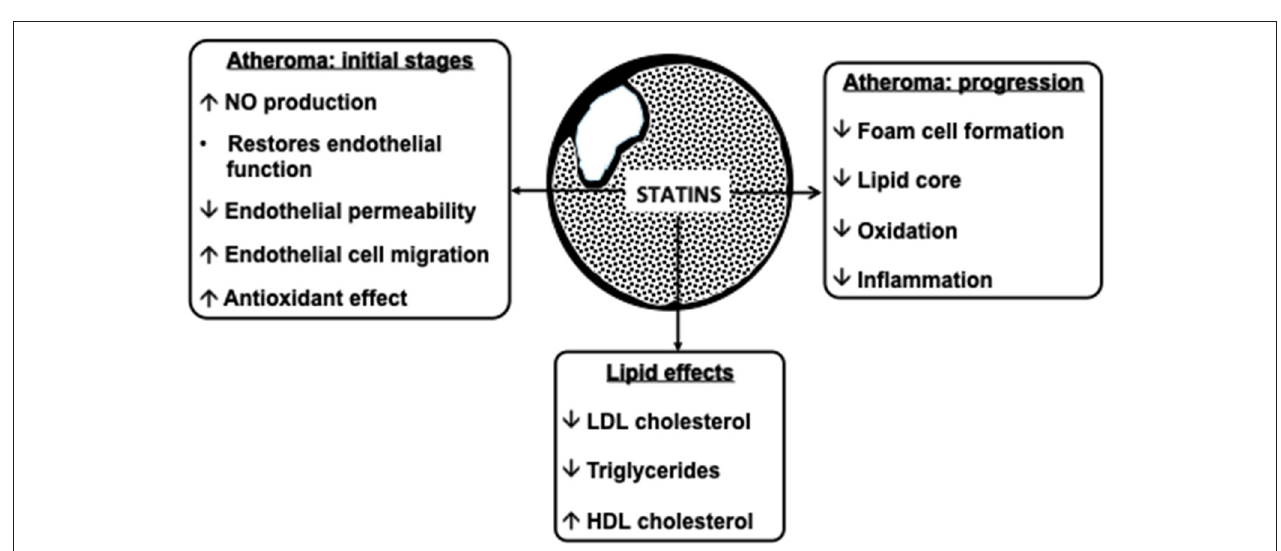
FIGURE 3 | Atheroprotective effects of statins. NO, nitric oxide; LDL, low-density lipoprotein; HDL, high-density lipoprotein.